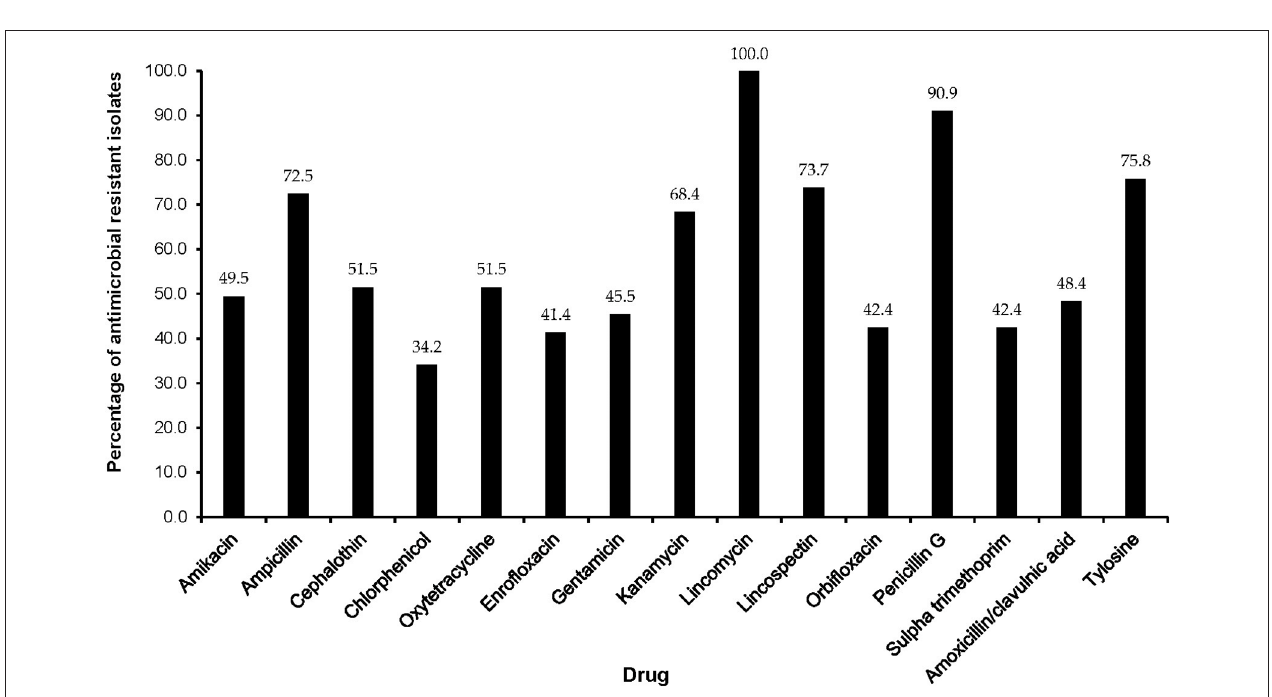
FIGURE 3 | Antimicrobial resistance patterns of multidrug resistant isolates from respiratory infections of dogs presented to a referral veterinary teaching hospital in South Africa, 2007-2013.